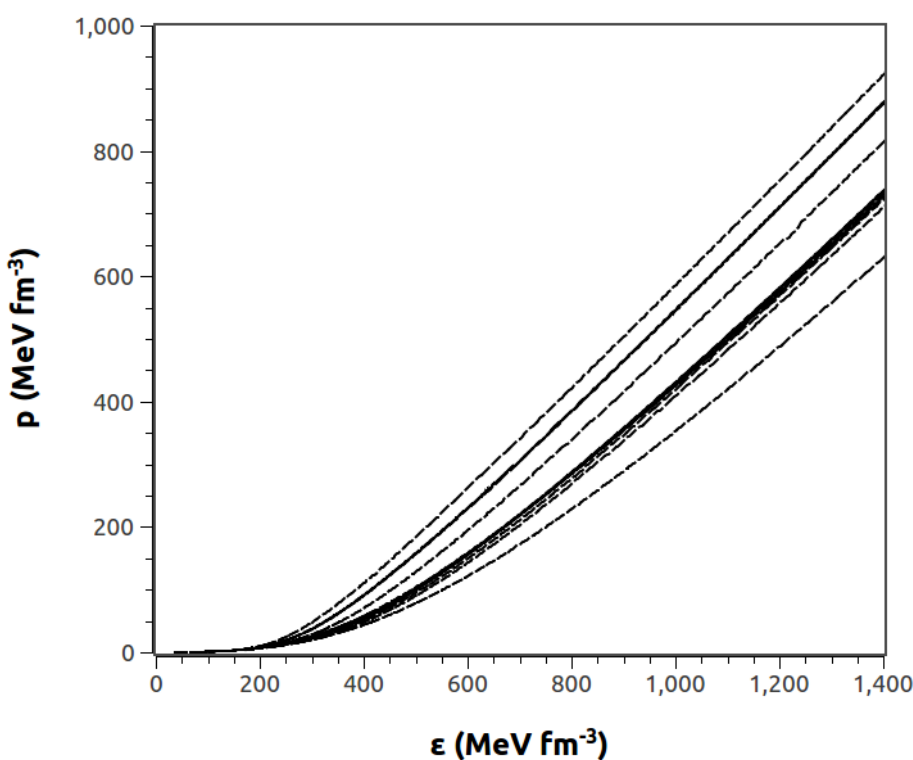
Figure 1. Equations of state used in this paper; see text for details.